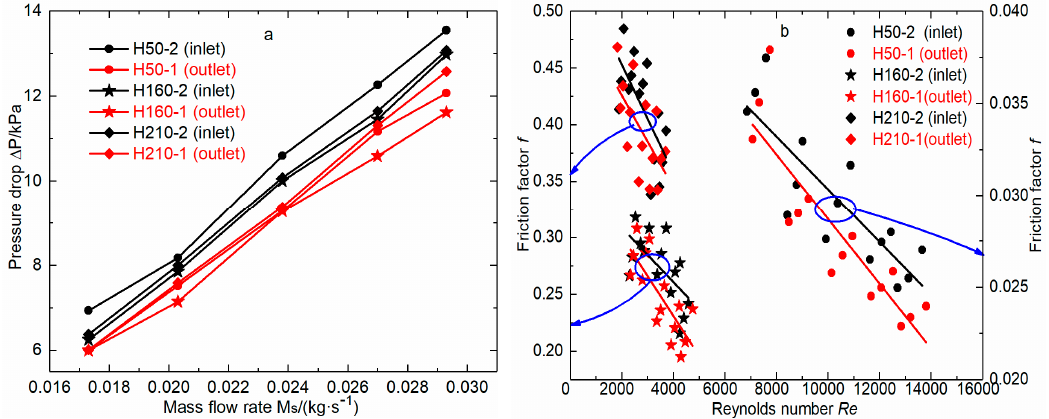
Figure 10. The resistance performance versus ( a ) mass flow rate and ( b ) Reynolds number.